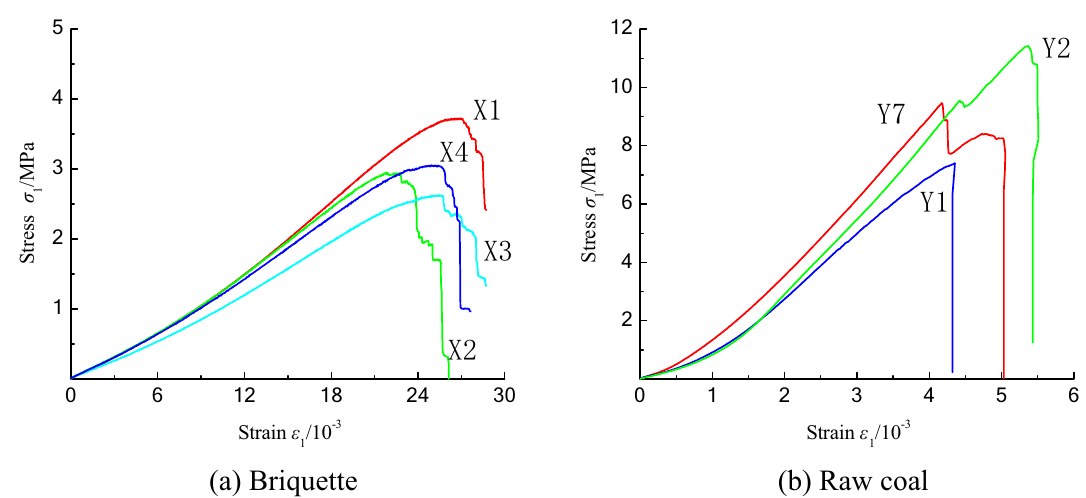
Figure 3. Stress–strain curves of coal samples under uniaxial